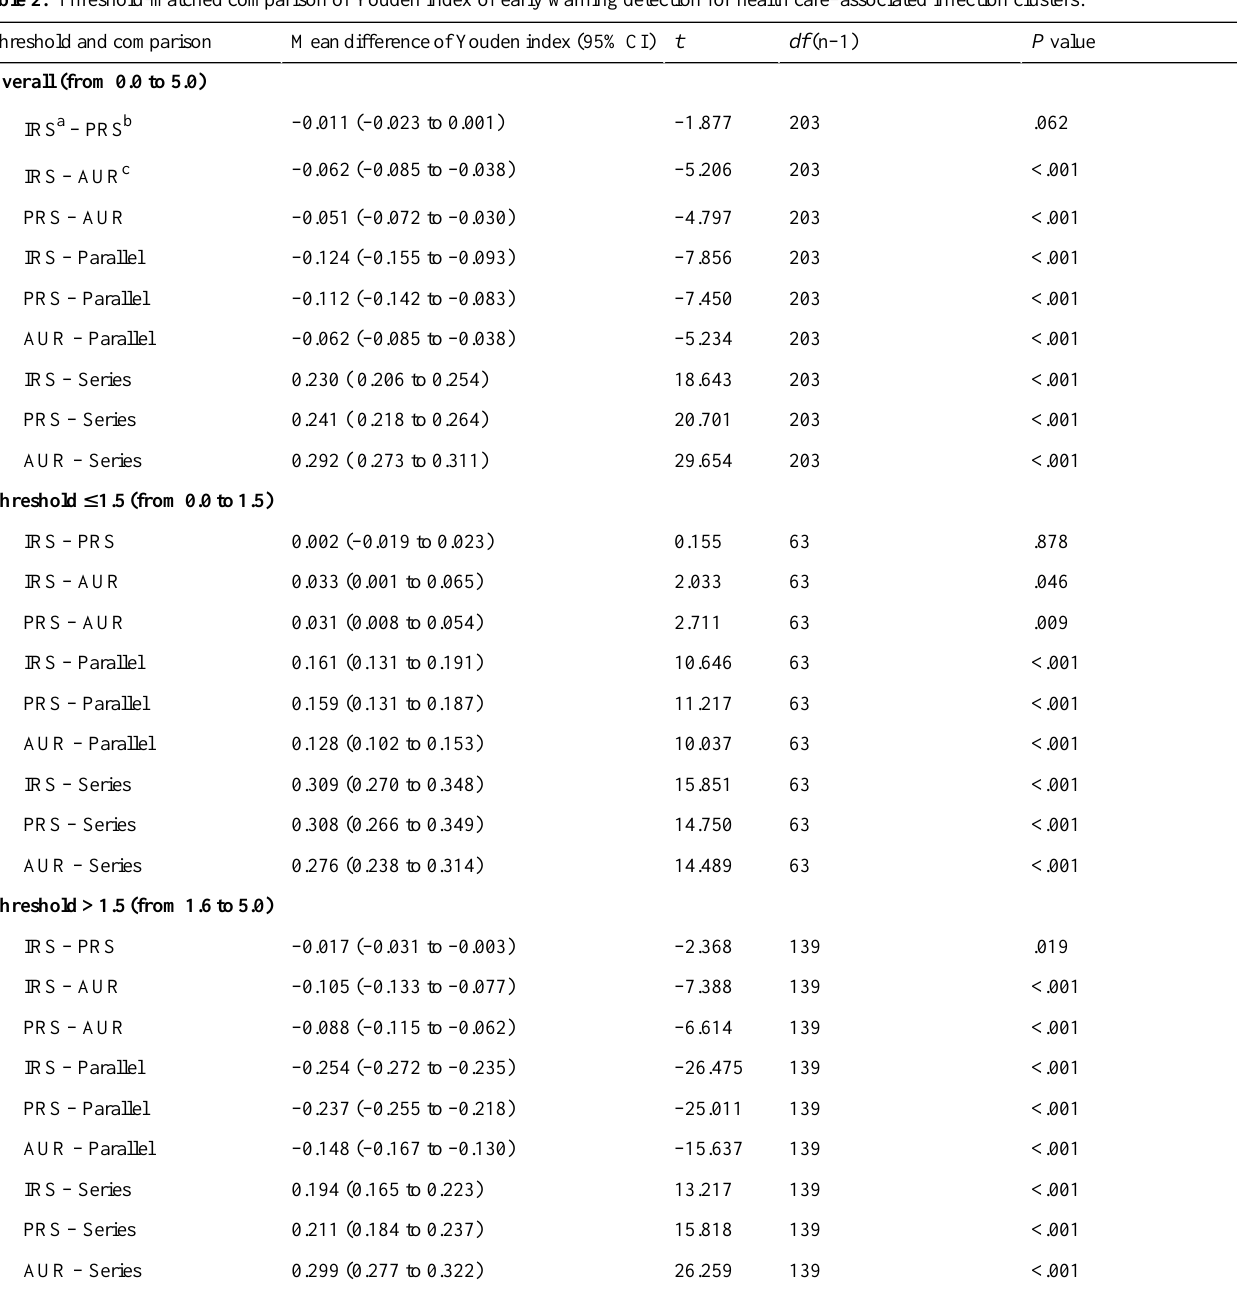
P value df (n–1) t Mean difference of Youden index (95% CI)Threshold and comparison